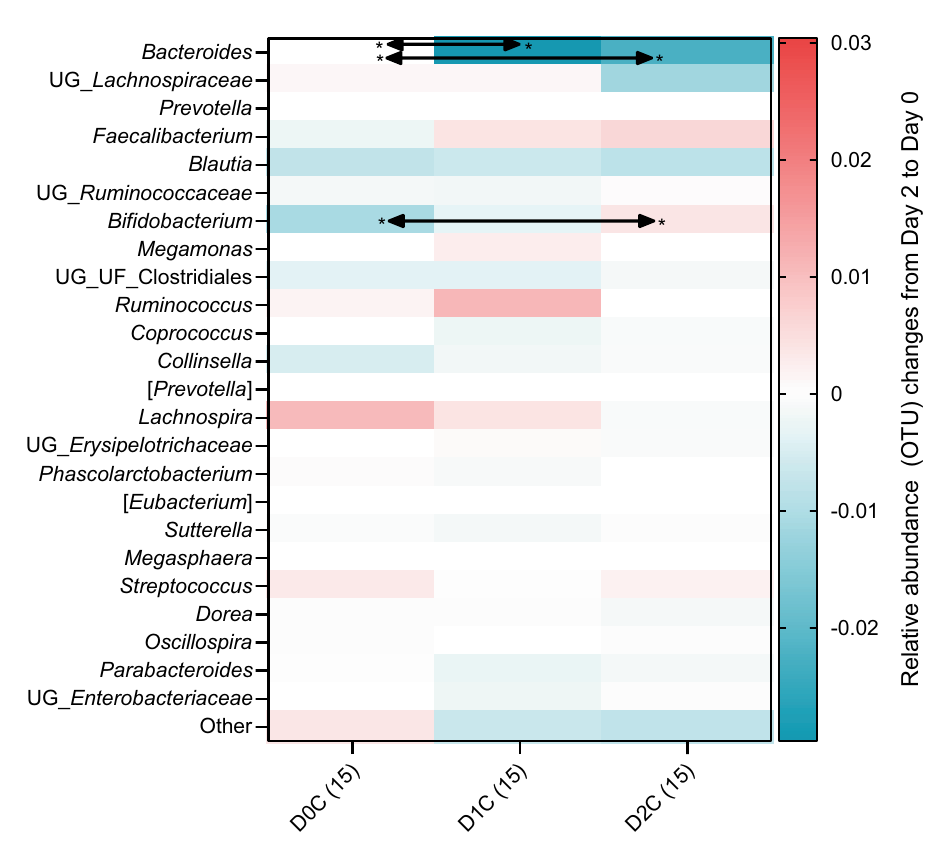
Figure 3. Heatmap of medians relative abundance changes of the major bacterial genera after two days of intervention for the three doses of mixed spices intervention. ‘Other’ was categorised as less than 1% of bacterial OTUs among the population. The relative abundance changes (Day 2 minus Day 0) in bacteria between various doses were analysed using Friedman’s test with Dunn’s multiple comparison and described as * adjusted p <